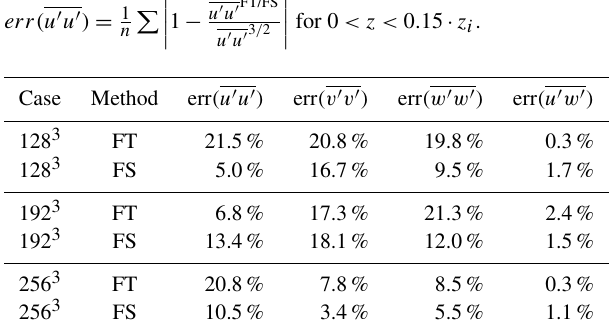
Table 2. Mean error in the variance profiles between the FT / FS methods and the 3 / 2 rule over the lower 15% of the domain. For example, the error of the streamwise variance is computed